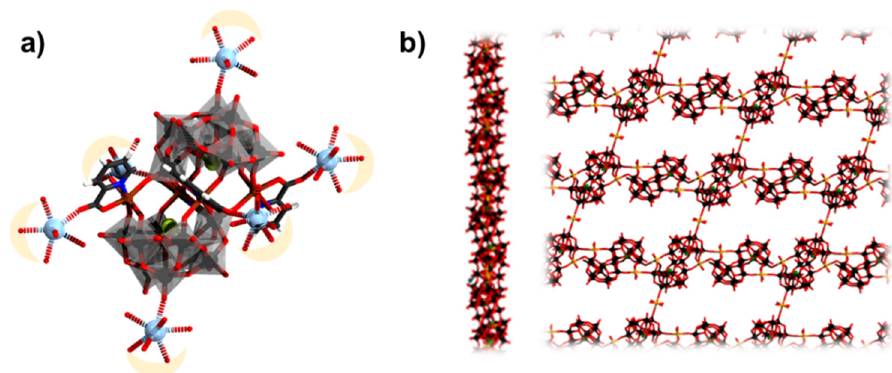
Figure 17. ( a ) La III cations grafted on [Fe II4 (H 2 O) 2 (pic) 4 ( β -SbW 9 O 33 ) 2 ] 10– ; ( b ) side and top view on two dimensional {Cu 0.5 Cl[Cu 2 (H 2 O) 4 ( β -BiW 10 O 35 ) 2 ]} 10 − . Color code: X = green (but covered), La = light blue, Fe = brown, {WO 6 } = gray octahedra, W = black, and O = red. H atoms on aqua ligands are omitted.